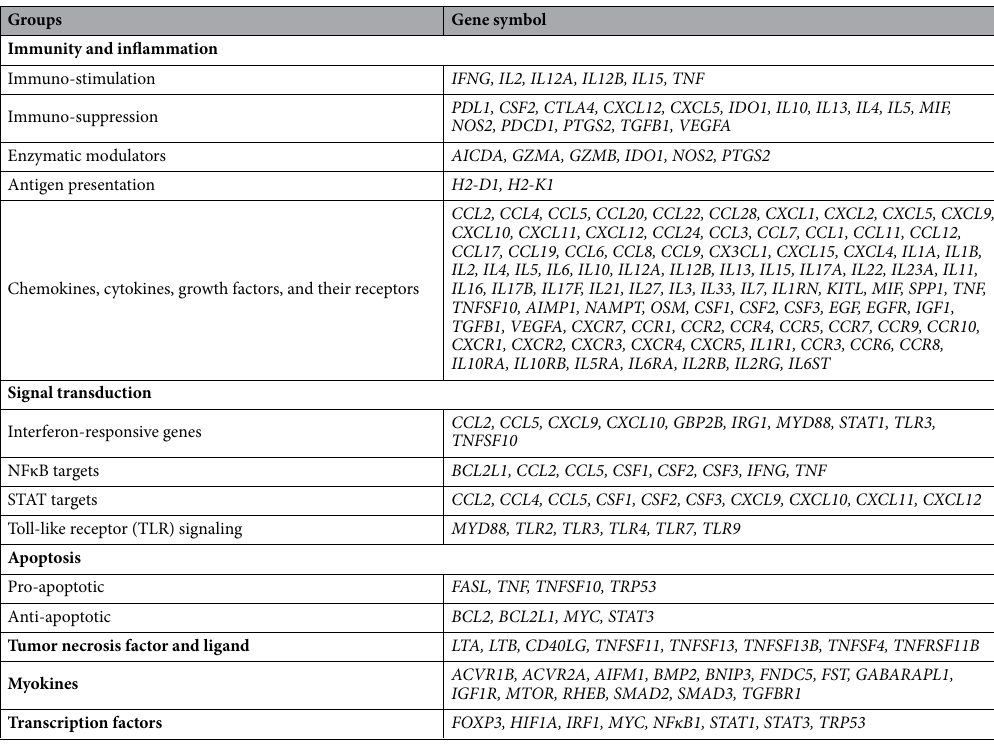
Table 1. List of the 144 studied genes sub-grouped to different